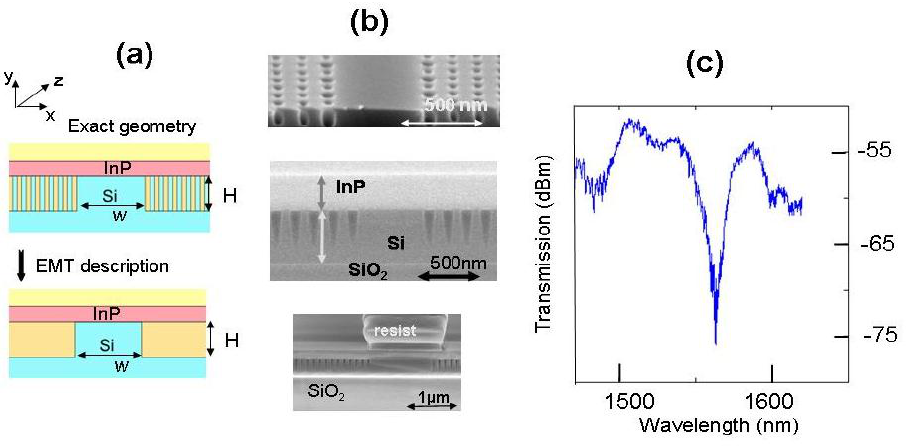
Figure 3. ( a ) Effective Medium Theory (EMT) representation of the 2D-PC used on the lateral cladding of the silicon waveguide, ( b ) SEM pictures: Top the silicon waveguide including the bi-periodic geometry Middle : the cleaved facet of the hybrid InP/Si waveguide Bottom : the resist line aligned on top to materialize the waveguide centre, ( c ) Spectrally resolved transmission of the hybrid